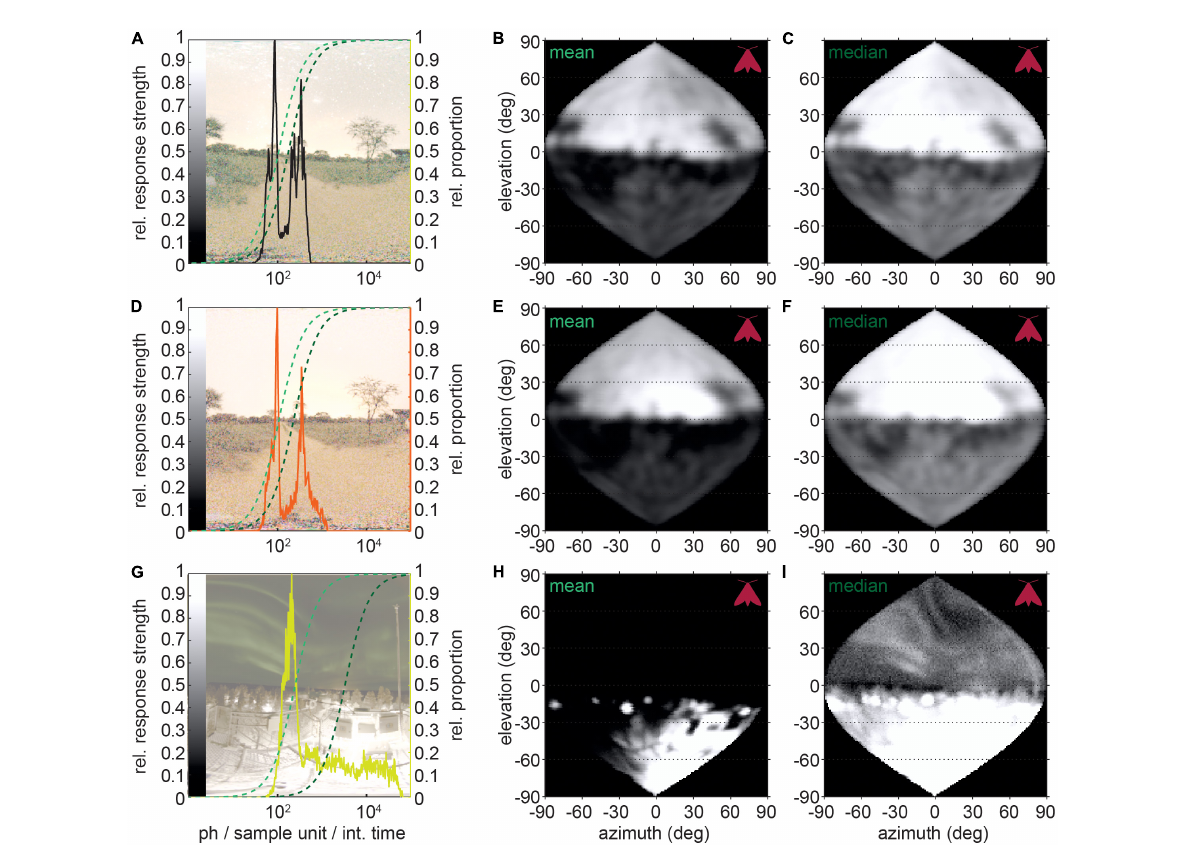
FIGURE5 Modeled neural responses to visual scenes with and without light pollution. (A,D,G) Natural scenes on moonless nights with different levels of light pollution: (A) no light pollution, (B) same location with indirect light pollution (sky glow) and (C) direct lighting of a high albedo ground. Overlaid are the distributions of photon numbers per sample unit with spatial summation applied for the hawkmoth D. elpenor . The photon distributions were mapped to a sigmoidal response curve spanning 2.5 log 10 -units of brightness, which were anchored either to the mean (dark green) or median (light green) of the distribution. Panels (B,E,H) show the responses for mean mapping, and panels (C,F,I) for median mapping, resampled to the sampling base of the